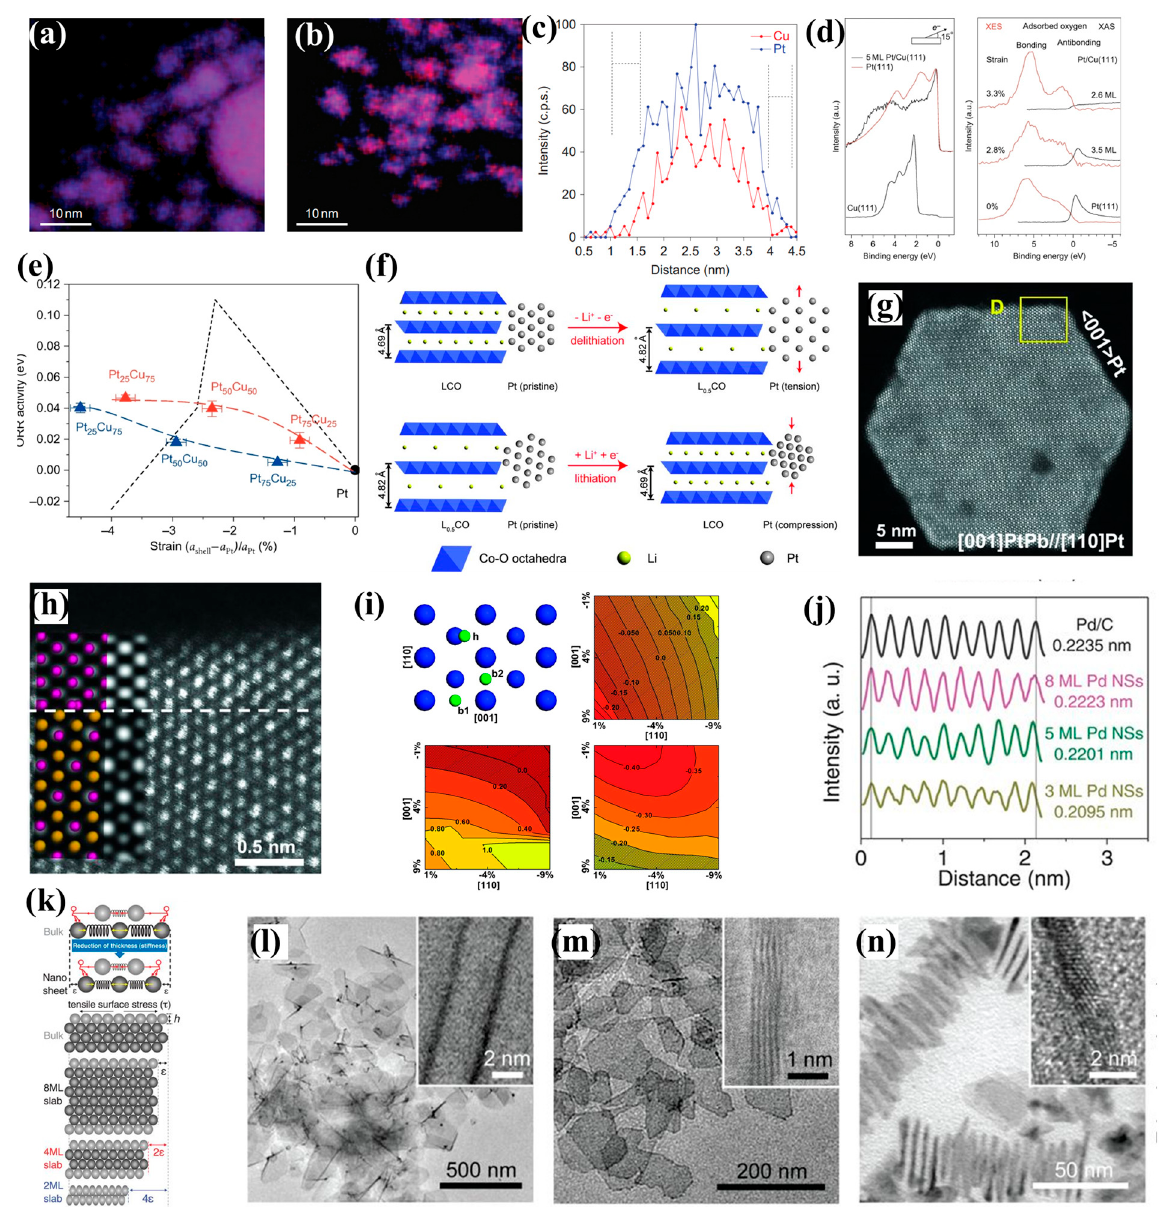
Figure 4. Elemental maps ( a , b ) and line profiles ( c ) of Pt − Cu bimetallic nanoparticle precursors and dealloyed active catalysts. ( d ) Surface science XAS and XES studies of single-crystal model systems that mimic dealloyed bimetallic core–shell structures. ( e ) Experimental and predicted relationships between electrocatalytic ORR activity and lattice strain. Reprinted with permission from Ref. [40]. Copyright 2010, Nature Chemistry. ( f ) Schematic of the lattice constant change in Li x CoO 2 substrates and how the lattice strains are induced to Pt NPs. Reprinted with permission from Ref. [35]. Copyright 2016, Science. ( g ) HAADF-STEM image from out-of-plate view. ( h ) High-resolution HAADF image from the selected area in ( g ). ( i ) DFT calculations of oxygen adsorption energy. Reprinted with permission from Ref. [41]. Copyright 2016, Science. ( j ) The intensity pro fi le and calculated av- erage d-spacing of (111) planes. ( k ) Mechanism of the generation of intrinsic strain in 2D transition metal nanosheets. h is the height of an atomic layer. ( l – n ) TEM images of as-prepared Pd nanosheets (NSs) with average thicknesses of 3 ML ( k ), 5 ML ( l ), and 8 ML ( m ), with insets depicting typical structures. Reprinted with permission from Ref. [42]. Copyright 2019, Science.